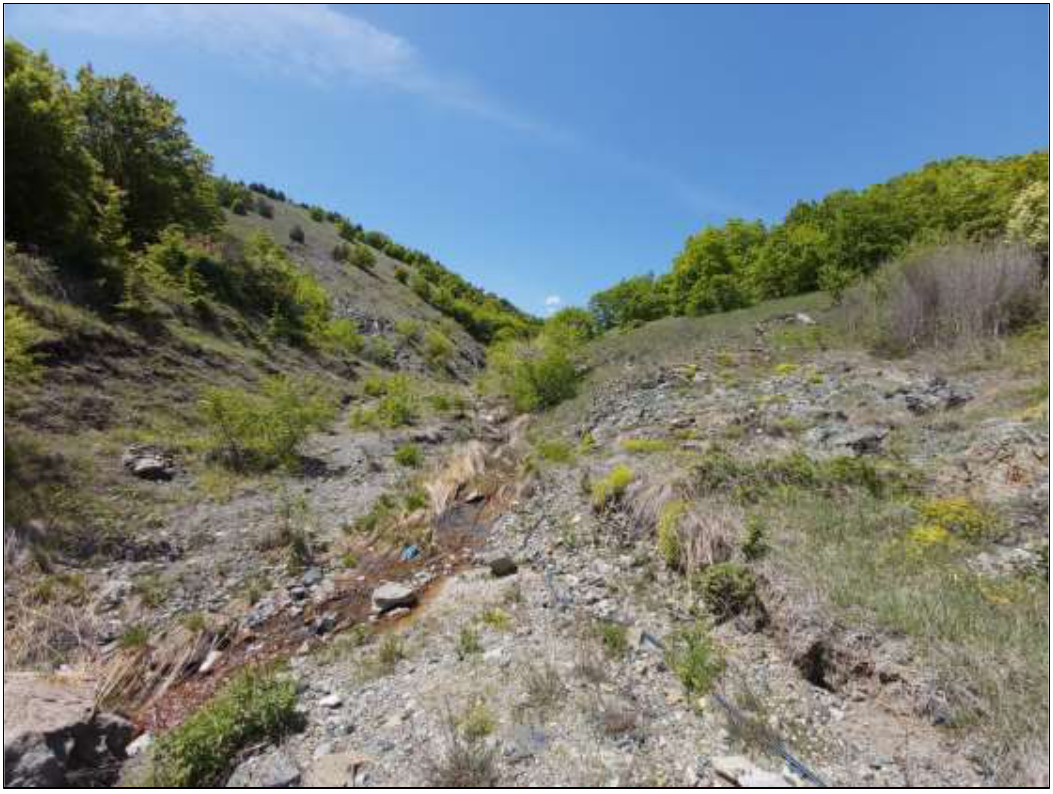
Figure 5. Miratovac, locality where Merodon testaceus Sack, 1913 was collected. (Photo: M. Vujić) Psilota atra (Fallén, 1817) (Fig. 6) Material examined: Belgrade, Vrčin, Lovački dom, N44 40 25 E20 37 22, UTM: DQ74,